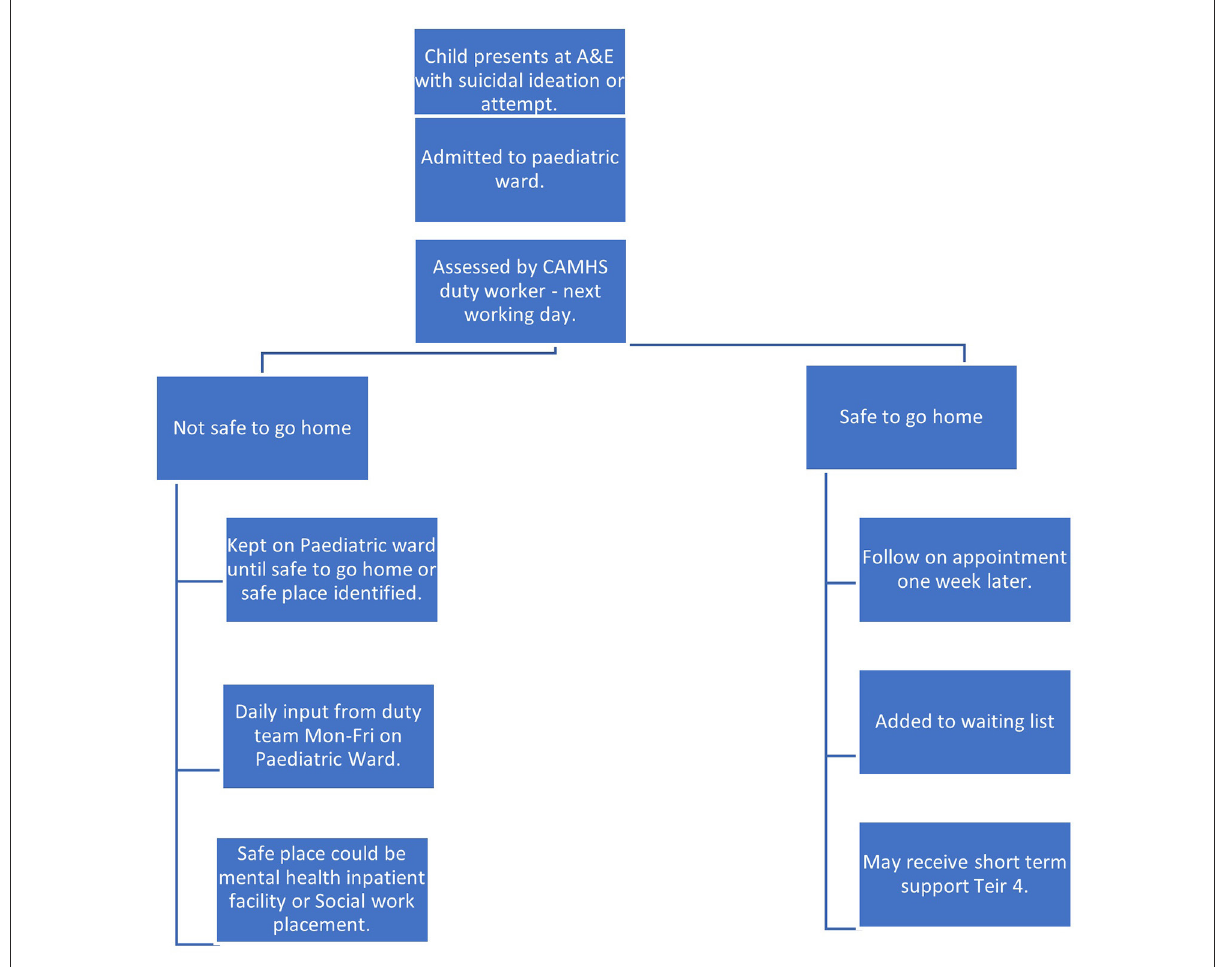
FIGURE8 Referral pathway for children referred to CAMHS from A&E (Site A).